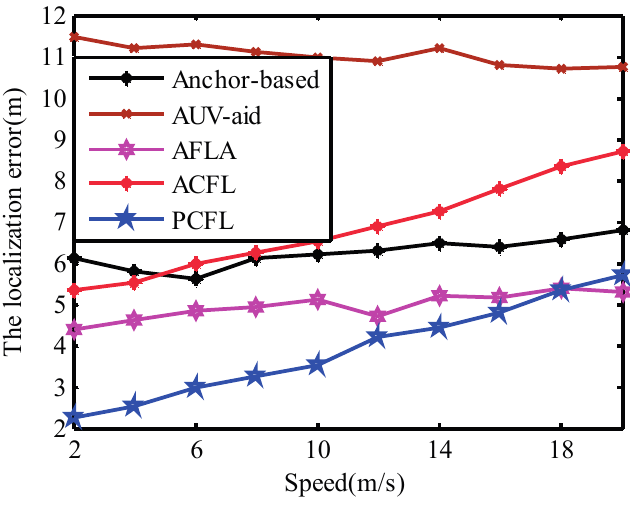
Figure 12. The speed of mobile nodes.